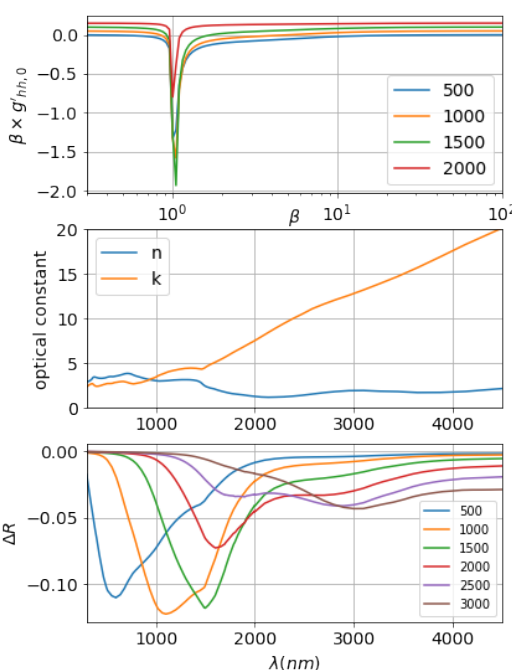
Figure 5. Random roughness effects on tungsten surface. Top panel: weighting function for wavelengths λ = 500 nm, 1000 nm, 1500 nm, and 2000 nm. Middle panel: optical dielectric constants for W at the visible and near-infrared range. Bottom panel: Reflection spectrum change of W surface for Gaussian surface with different correlation lengths. Legend: 2.22 l in nm.